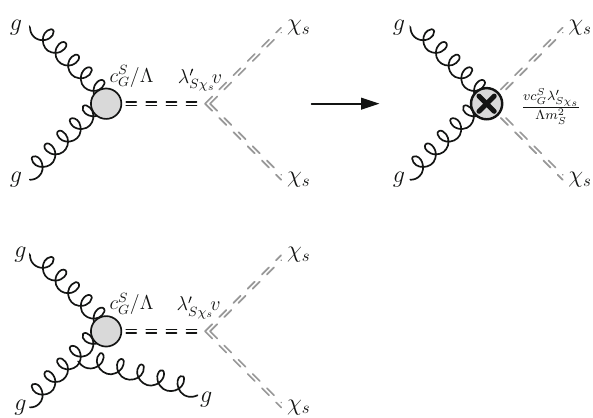
Fig. 13 Relevant diagrams contributing to nuclear interaction with scalar DM (first row) and corresponding DM observables at hadron colliders (monojet, second row), turning on the interactions ∼ c S ∼ λ (cid:3) S χ